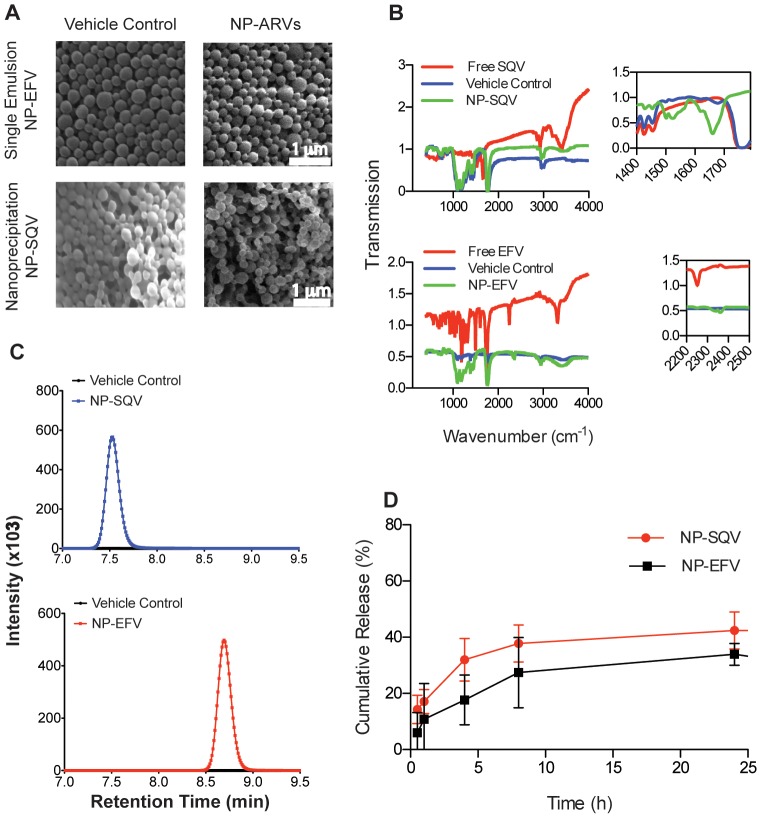
Properties of PLGA nanoparticles loaded with efavirenz or saquinavir.(A) Scanning electron photomicrographs (magnification, 15,000×) of nanoparticles encapsulated with antiretroviral drugs efavirenz (NP-EFV) or saquinavir (NP-SQV). (B) Fourier transform infrared spectroscopy (FTIR) confirmation of the antiretroviral drugs loaded into PLGA nanoparticles. Insets show characteristic frequencies of SQV and EFV and the PLGA polymer (Vehicle Control). (C) HPLC chromatograms of vehicle control (black), SQV (blue) and EFV (red) nanoparticles showing the detection of SQV and EFV only in ARV loaded nanoparticles. No drug peak was detected in the vehicle control nanoparticles. (D) Cumulative release of EFV and SQV from nanoparticles in a vaginal fluid simulant (VFS) showing the release of SQV and EFV over 24 h.